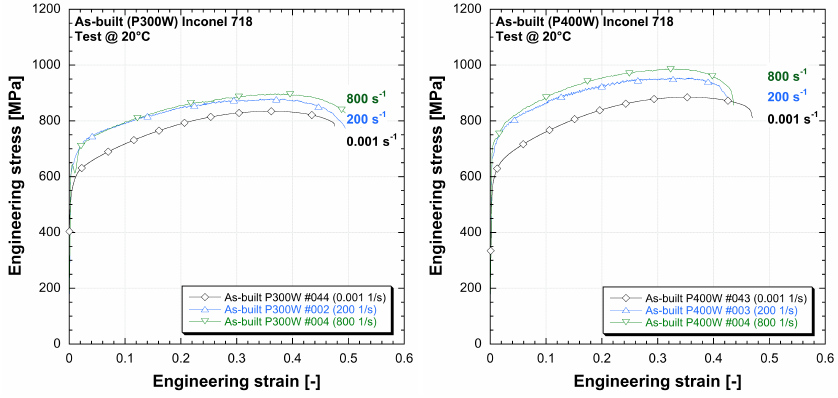
Figure 4: Engineering flow stress for both as-built materials.